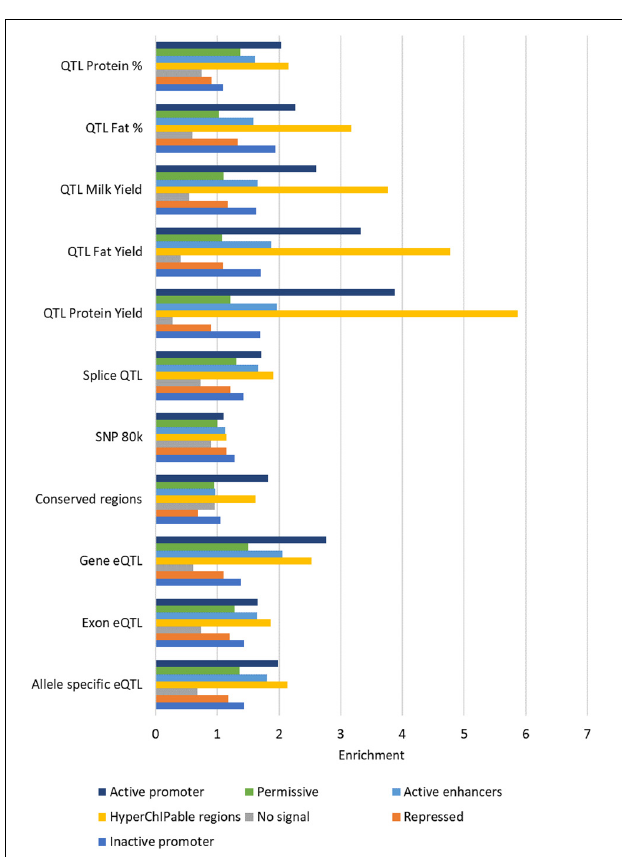
FIGURE 8 | Average enrichment of chromatin states for each SNP dataset. Enrichment for each state averaged across tissues.